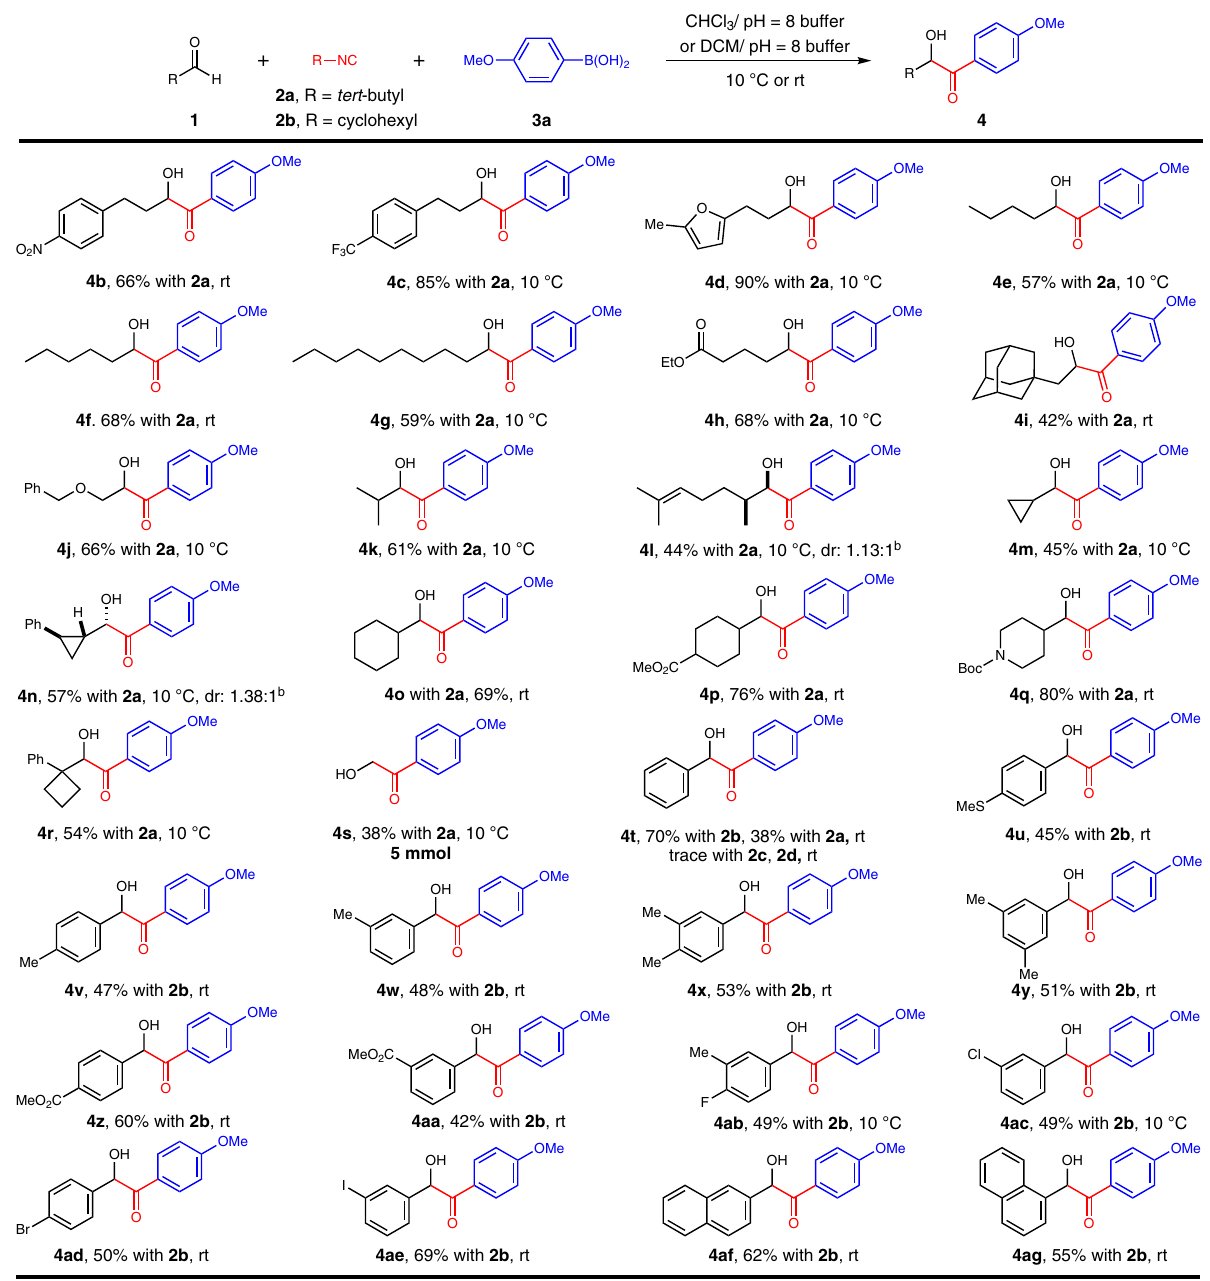
Fig. 2 Scope of aldehydes a . Reaction conditions: a aldehyde 1 (0.2 mmol, 1 equiv), 2a (0.3 mmol), 3a (0.36 mmol), and CHCl 3 /pH = 8 buffer (7:3, 1 mL) under an argon atmosphere for 24 hours unless otherwise speci fi ed; b The dr was determined by 1 H NMR analysis. c aldehyde 1 (0.2 mmol, 1 equiv), 2b (0.3 mmol), 3a (0.36 mmol), and DCM/pH = 8 buffer (7:3, 1 mL) under an argon atmosphere for 24